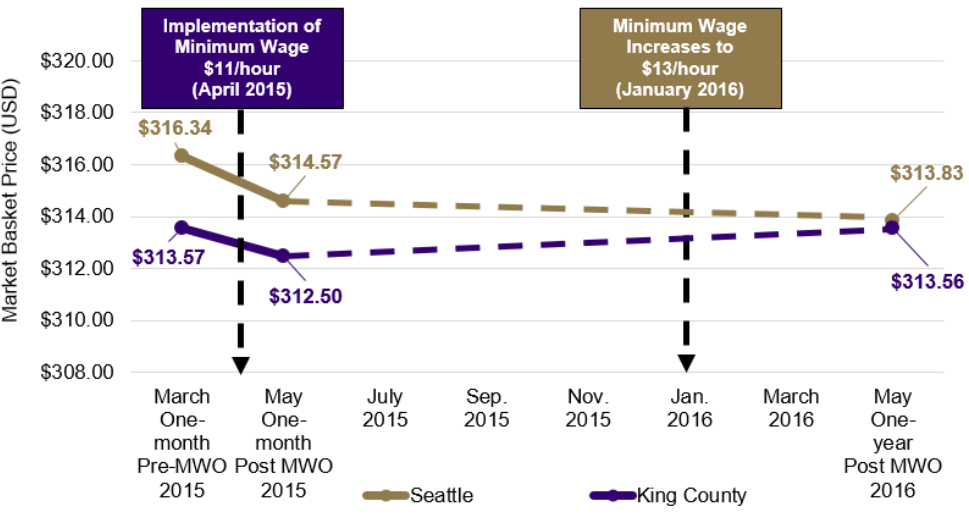
Figure 1. Average market basket cost before and after two phases of minimum wage law implementation in affected Seattle as compared to unaffected King County. MWO = minimum wage ordinance. Dashed lines indicated periods where data were not collected.